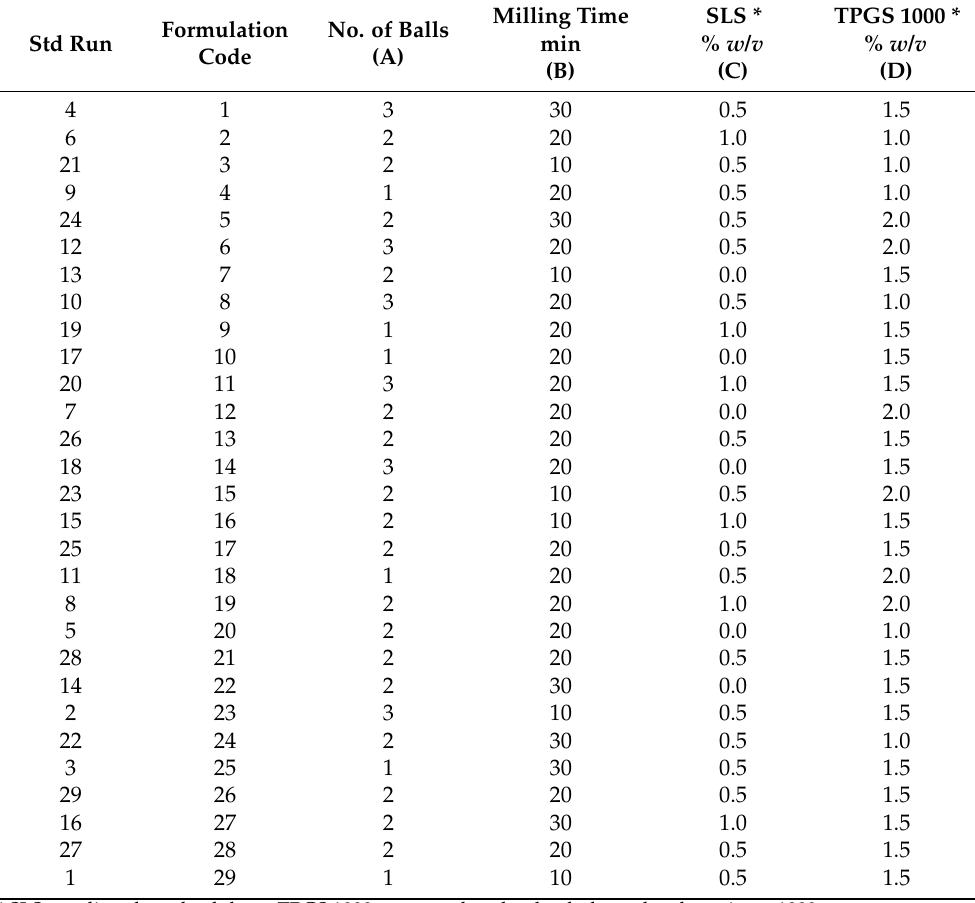
Table 1. Summary of the Box–Behnken design (BBD)